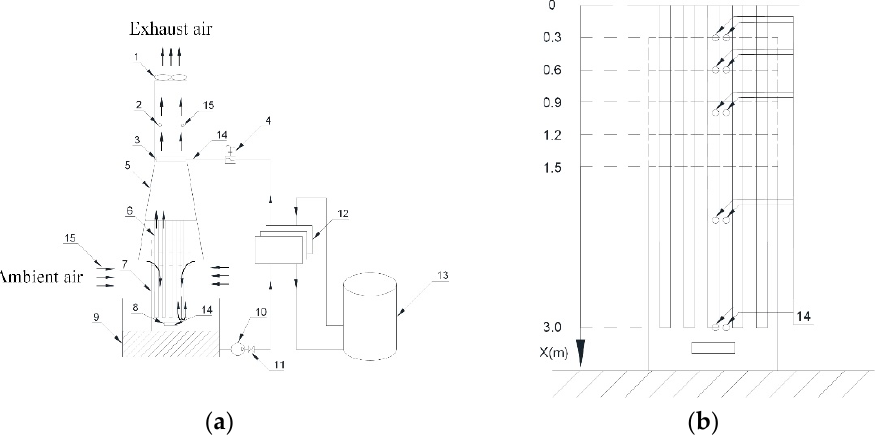
Figure 3. ( a ) The scheme of the experimental system and ( b ) the arrangement of the temperature measurement points along the tubes: 1—frequency conversion fan; 2—hot-wire anemometer; 3—water